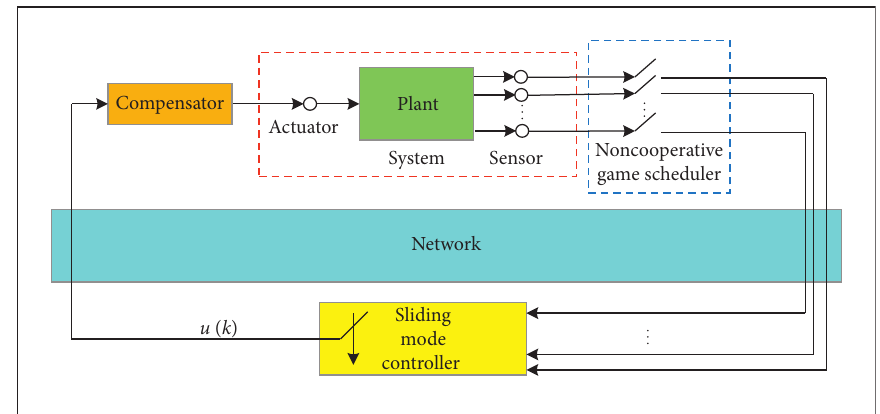
Figure 1: The structure of NCS with noncooperative game